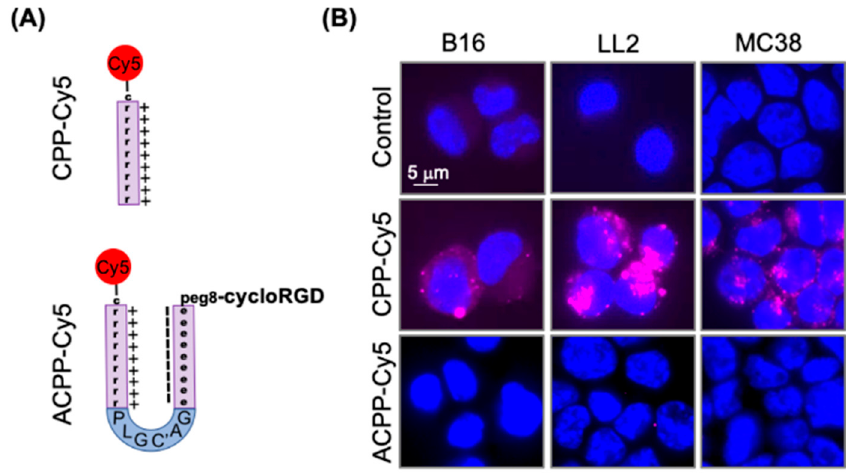
rescence (Magenta). Nuclei stained with DAPI (Blue).